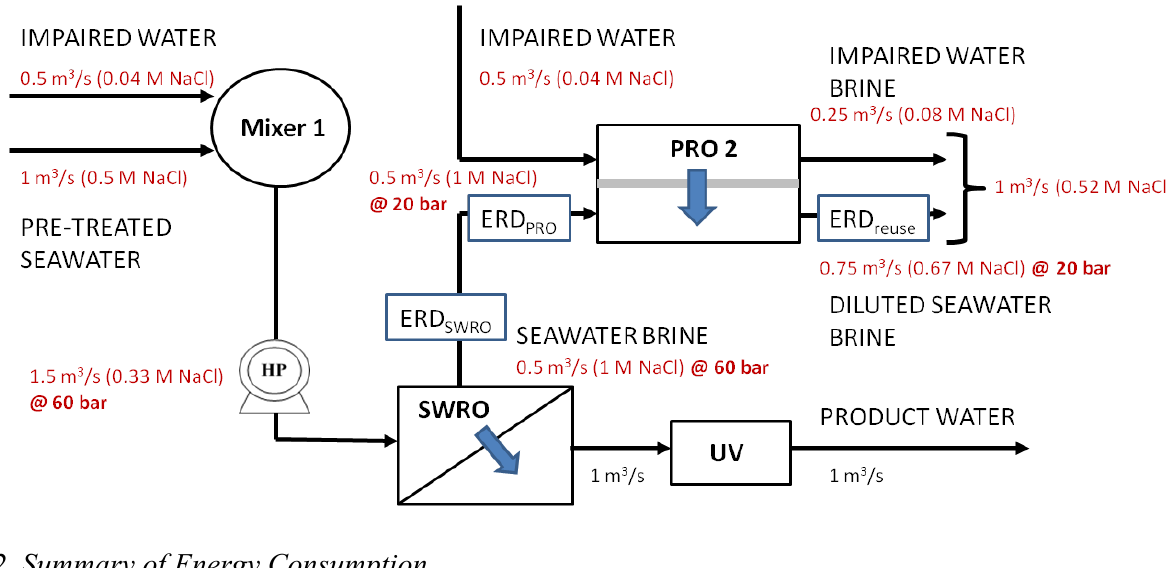
Figure 8. Configuration Mixer 1, diluted seawater water feed using impaired water (water reuse brine) with direct mixing and single-stage recovery of osmotic energy.